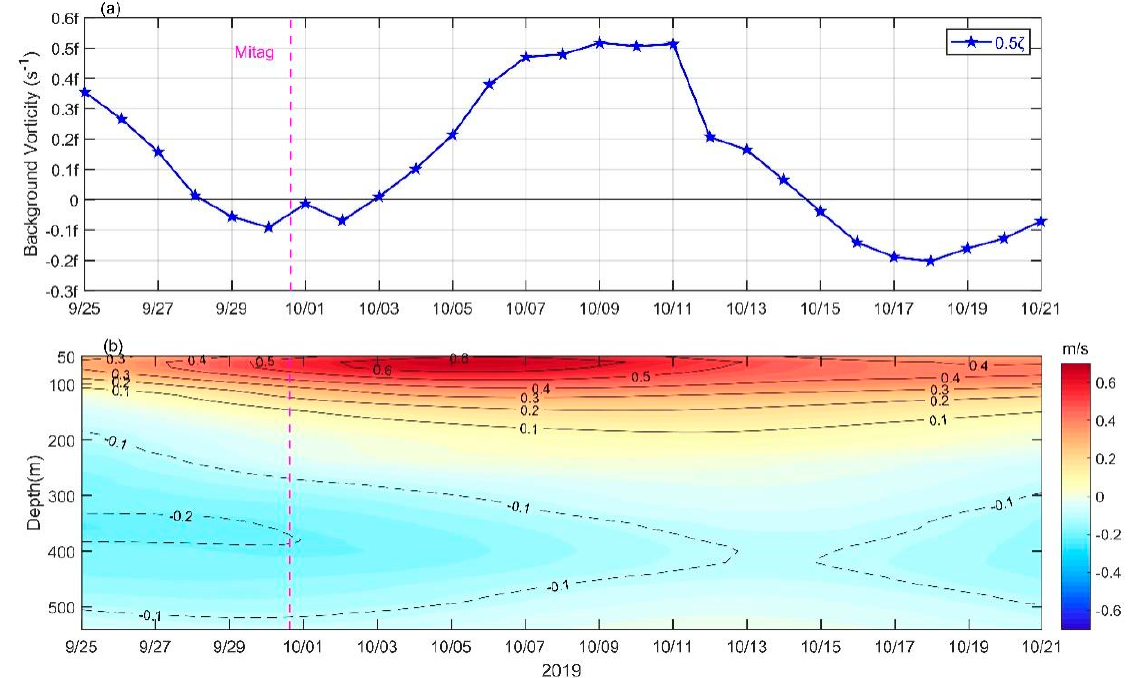
Figure 14. ( a ) Time evolution of the background vorticity at the mooring. The horizontal black solid line denotes the vorticity of zero. ( b ) Time–depth plot of 10-day low-pass filtered meridional raw currents at the mooring. Solid (dashed) contours, starting at 0.1 ( − 0.1) m/s, denote positive (negative) values. Intervals between adjacent contours are 0.1 m/s. In ( a , b ), the vertical purple dashed lines indicate the time of closest approach to the mooring by the center of typhoon Mitag.